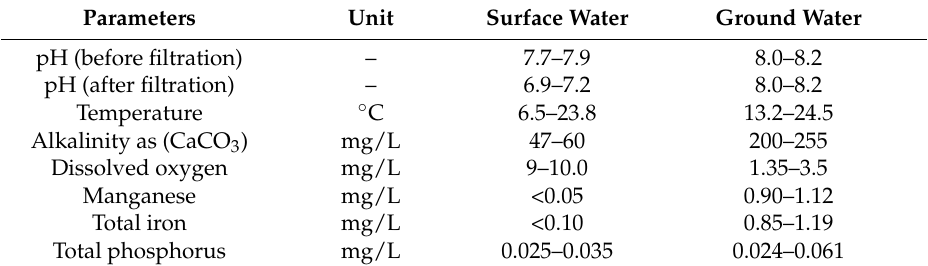
Figure 2. Ammonium removal performance of ( a ) normal quartz sands filter and ( b ) MeOx filter for treating surface water. Water temperature was 13–16 °C. Table 1. Water quality of surface water and groundwater used in the pilot-scale filter system.